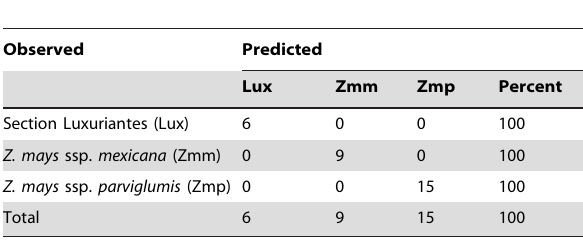
Table 2. Two-variable (A-1-B-3/3, A-1-B-1/1) MDA classification matrix of known assemblages (direct method).